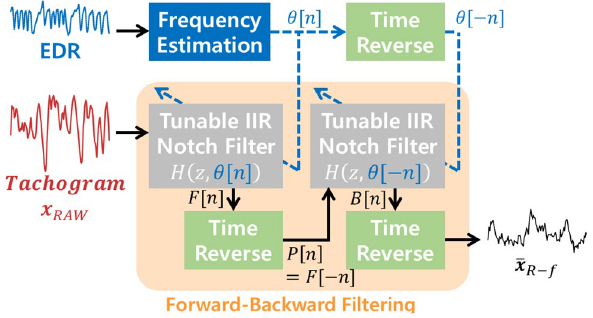
Figure 3. Tachogram decomposition process of ZLE. The ZLE is composed of ( a ) instantaneous RR θ [ n ] estimation and ( b ) time-variant forward–backward IIR notch